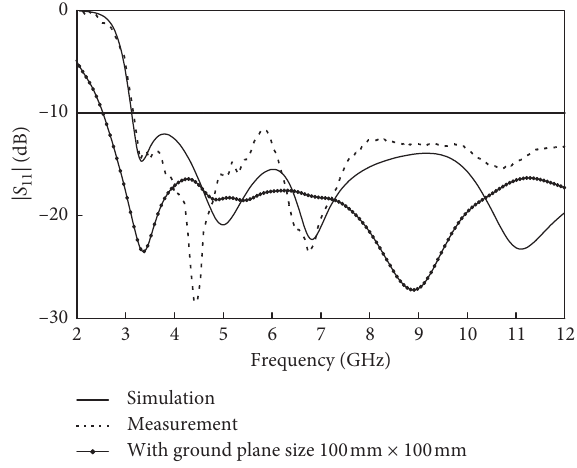
Figure 10: | S 11 | versus frequency of the